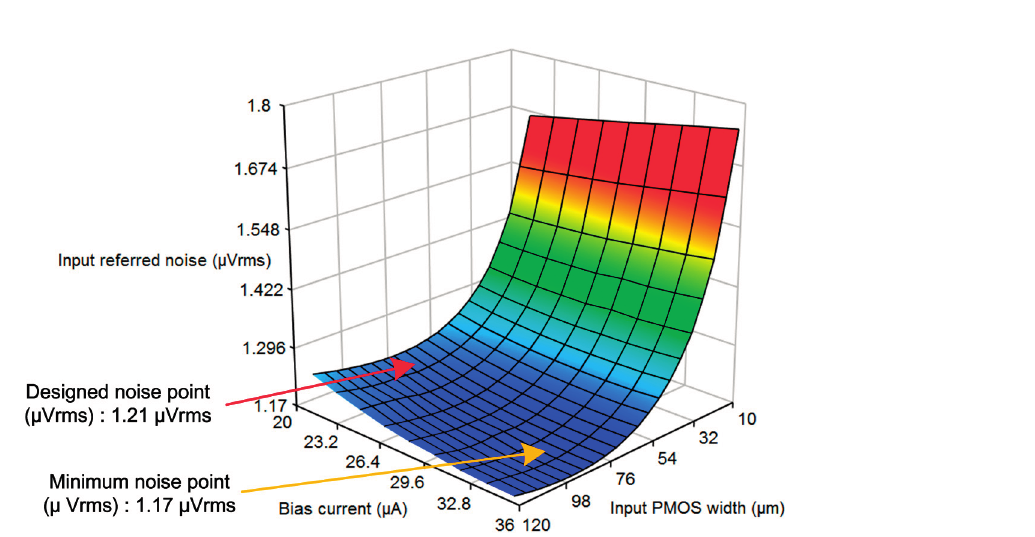
Figure 7. IRN optimization with input PMOS width and bias